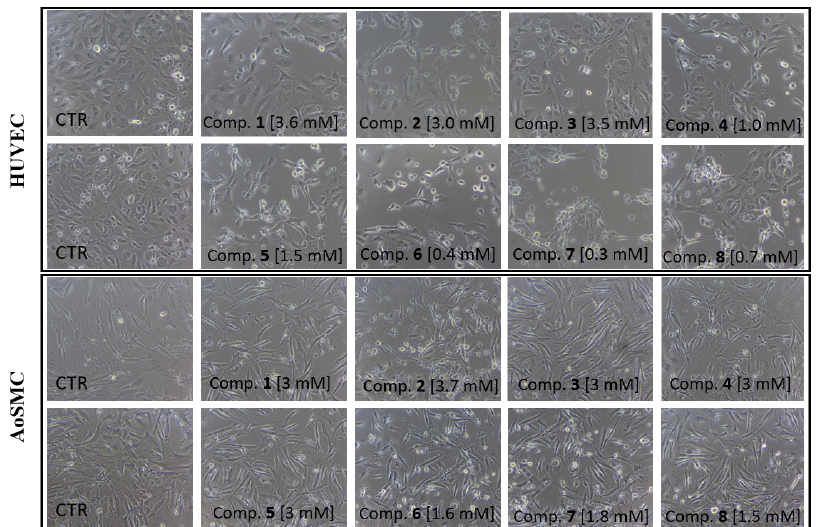
Figure 3. Effect of compounds 1 – 8 on HUVEC and AoSMC viability and morphology after 24-h incubation. Cells were cultured without (control, CTR) and in the presence of compounds 1 – 8 at a concentration of 0.006–5.0 mM. Representative cell images are shown for concentrations corresponding to IC50 values or 3 mM (100 ‐ fold magnification). Metformin was found to not affect the viability and morphology of HUVEC and AoSMC cells in our previous study [28].